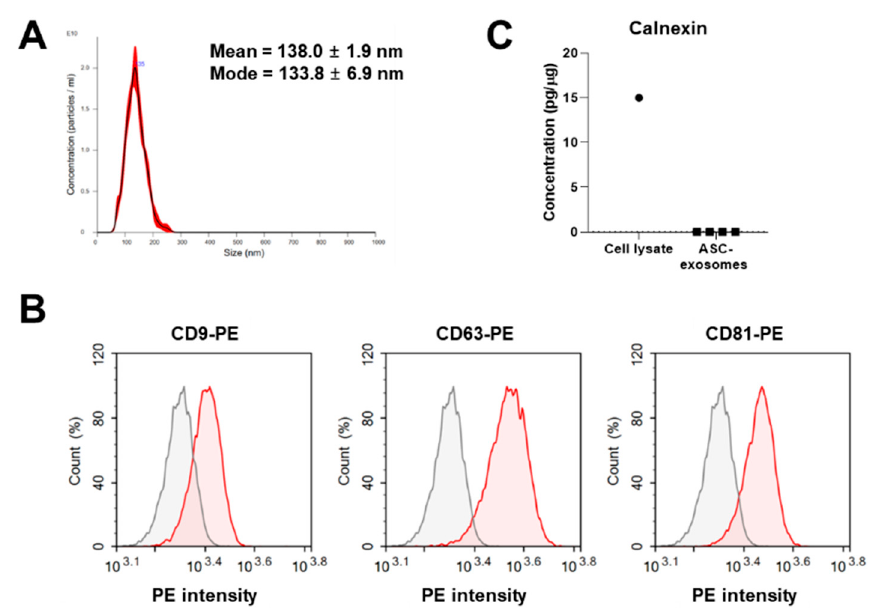
Figure 1. Characteristics of human adipose tissue-derived mesenchymal stem / stromal cells (ASC-exosomes). ( A ) A representative Nanoparticle Tracking Analysis (NTA) histogram of ASC-exosomes. ( B ) Bead-based flow cytometric analysis of ASC-exosomes with antibodies for indicated proteins. ASC-exosomes were captured by Dynabeads coated with antibodies for exosome surface markers including cluster of di ff erentiation 9 (CD9), CD63, or CD81. Then, the phycoerythrin (PE)-conjugated antibodies were reacted with captured ASC-exosomes as indicated. The mouse immunoglobulin G1 (IgG1)-PE was used as an isotype negative control. Gray peaks, PE fluorescence count from isotype control antibody; red peaks, PE fluorescence count from antibodies for indicated proteins (CD9, CD63, and CD81); X -axis, signal intensity of PE. ( C ) Concentration of calnexin measured by ELISA. n = 4 for ASC-exosomes and n = 1 for cell lysates performed in duplicate.